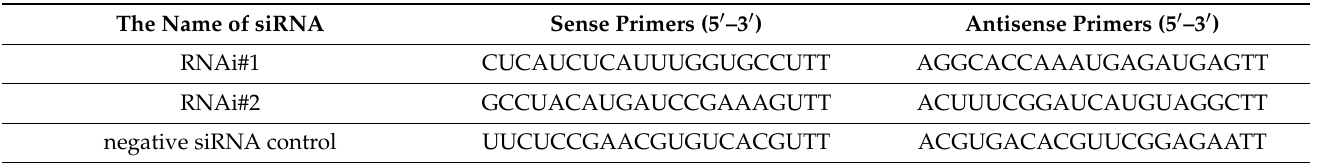
Table 4. Sheet of siRNAs